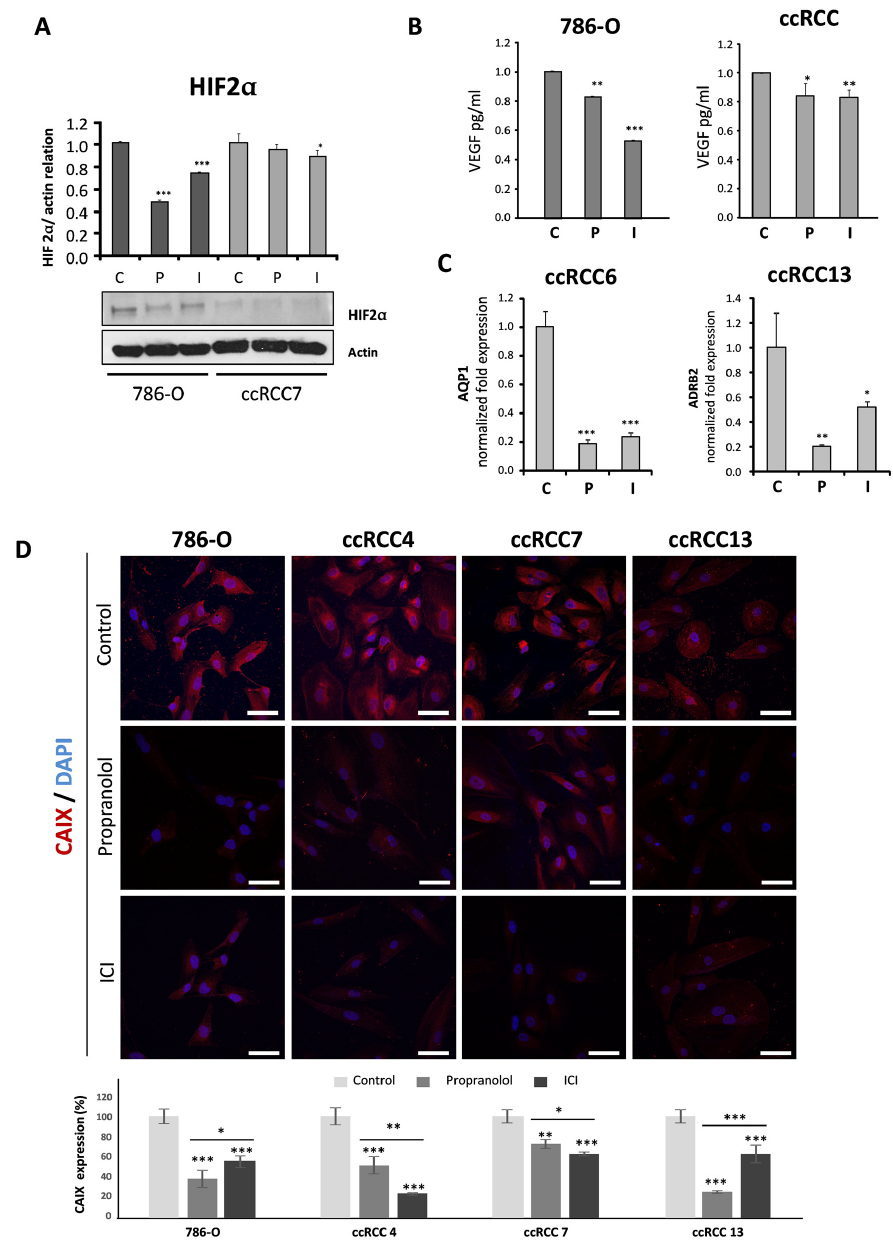
Figure 2. E ff ects of ADRB antagonists on VHL gene targets. ( A ). HIF-2 α protein expression on 786-O and ccRCC cells after treatment with 100 µ M propranolol or ICI for 72 h. Protein cell lysates were analyzed by Western blot, actin was used as loading control and for normalized quantification (representative assay). ( B ). Secreted VEGF levels in supernatants of cells treated with 100 µ M propranolol or ICI for 48 h were measured by ELISA. VEGF data from ccRCC represents the average of three di ff erent tumor samples. ( C ). mRNA quantification of the HIF target genes AQP-1 on ccRCC primary tumors treated with 100 µ M propranolol or ICI for 72 h. ( D ). Immunofluorescence detection and confocal microscopy representative images from 786-O and ccRCC cultures treated with 100 µ M PBS, propranolol, or ICI for 48 h. Up, mouse anti-human CAIX antibody stains (red) and DAPI nuclear staining (blue) merged images. Down, relative quantification of CAIX expression on each cell line after treatment. For quantification procedures, 20–50 cells were measured for CAIX intensity from 3 replicates per condition. Scale bars represent 50 µ m. All data are based on 3 independent experiments. Abbreviations: C, P, and I for control, propranolol, and ICI, respectively. Error bars denote ± SEM. Student’s t -test: * p < 0.05; ** p < 0.01; *** p <